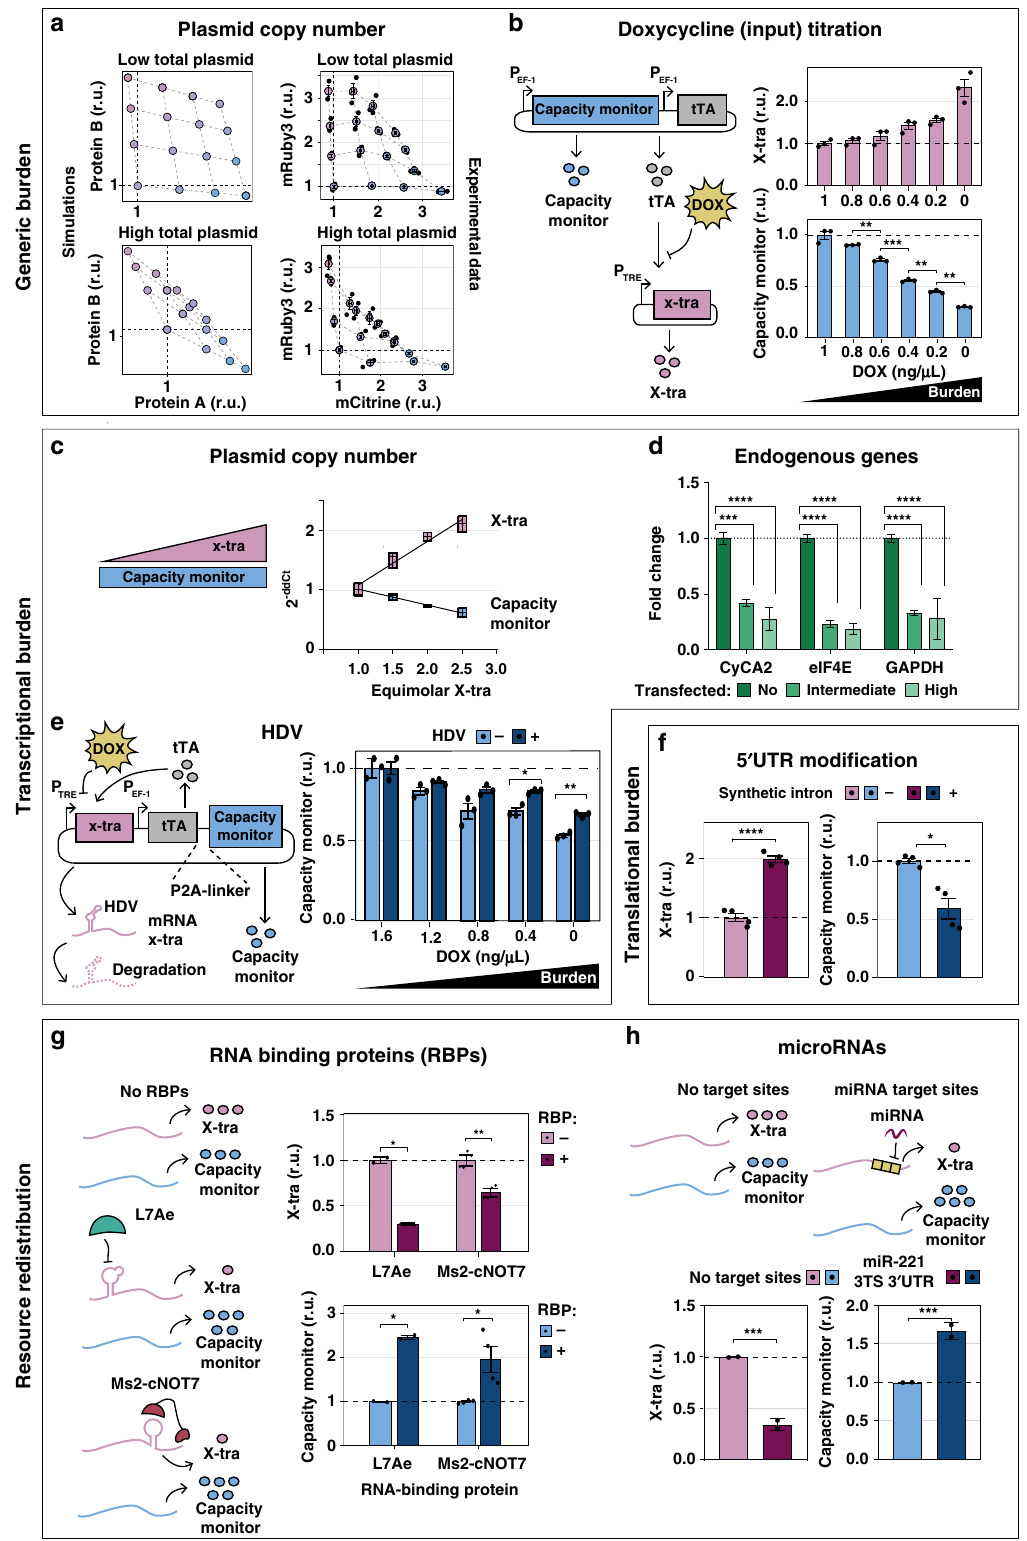
1:1 to 2:1 and observed a progressive, albeit not dramatic